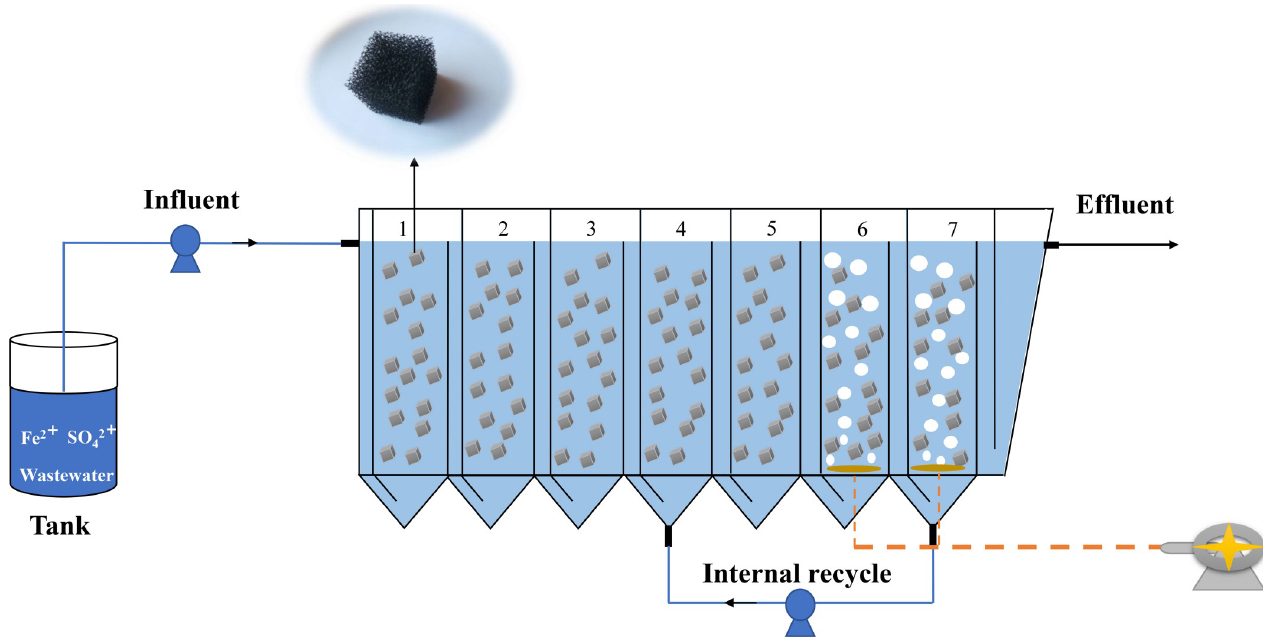
Fig 1. Schematic of the ABR biological reactor used for remediation of the ASP flooding process water. anaerobic zones (1-3); anoxic zones (4, 5); and aerobic zones (6, 7).